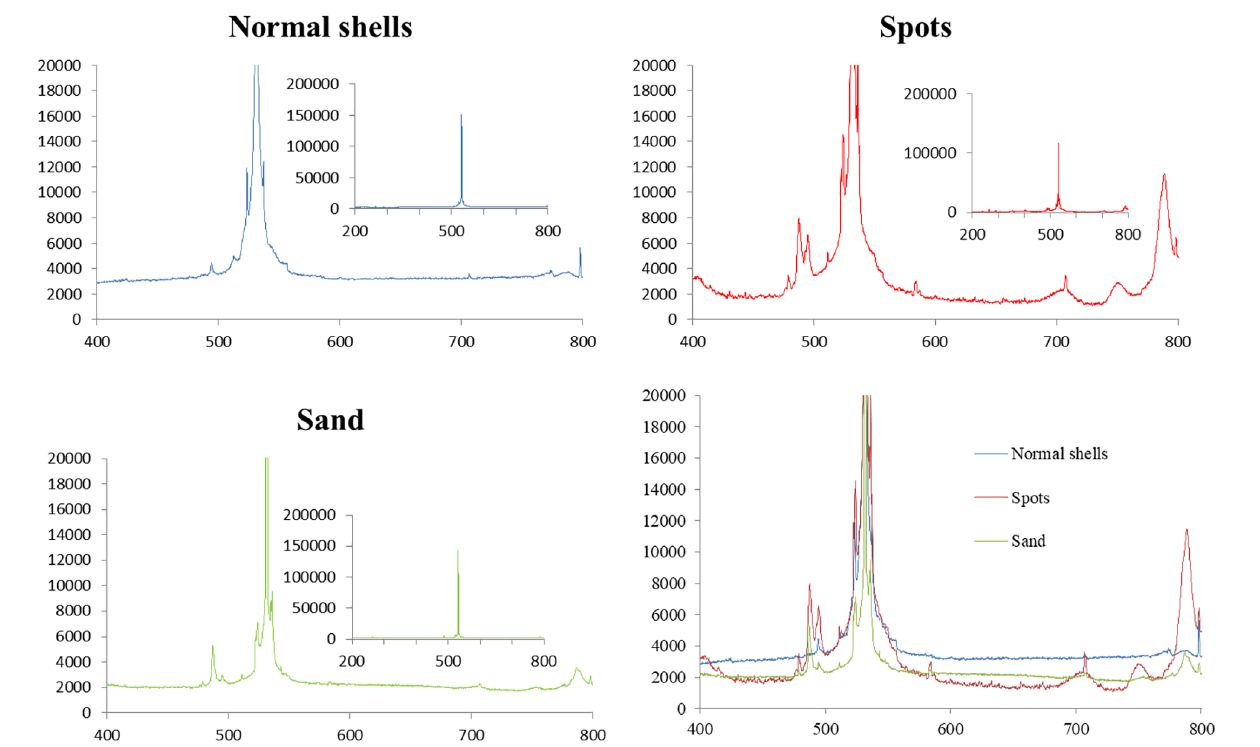
FIGURE 6 | Results of laser Raman spectroscopic analysis of normal shells, shells with spots, and sand.